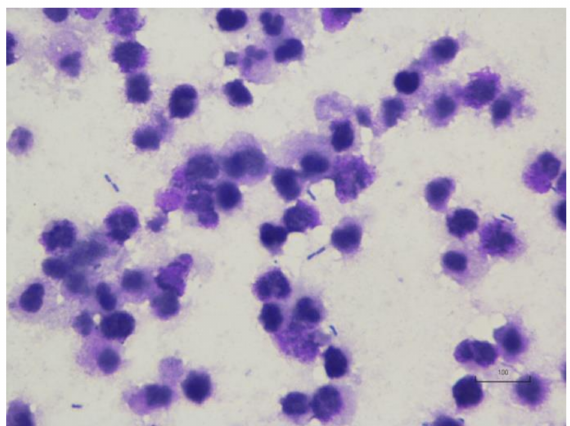
Figure 5. Cytology of pus of the uterus in a lion ( Panthera leo ) with pyometra. There are numerous degenerative neutrophils and many bacterial rods.